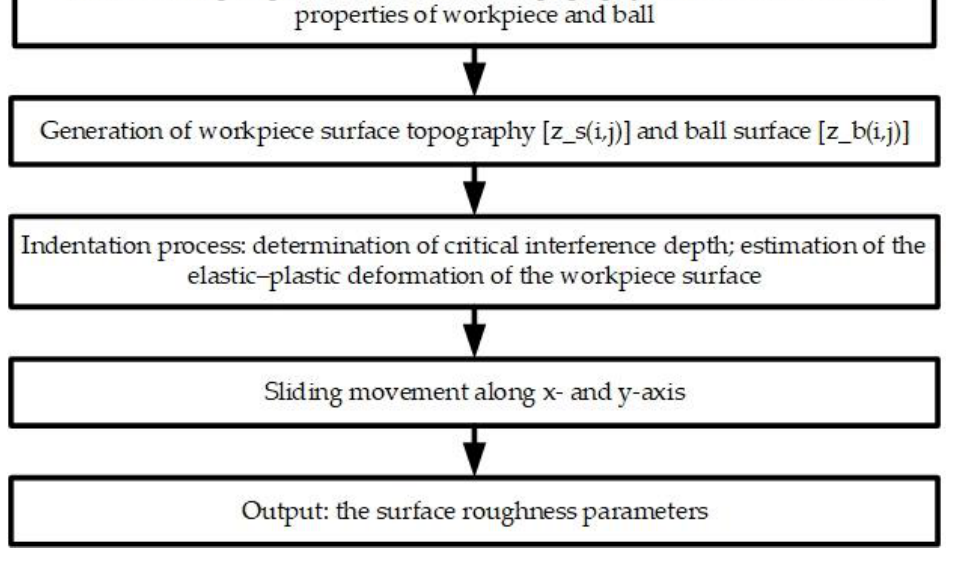
Figure 2. Simulation procedure of the smoothing small ball-burnishing process.